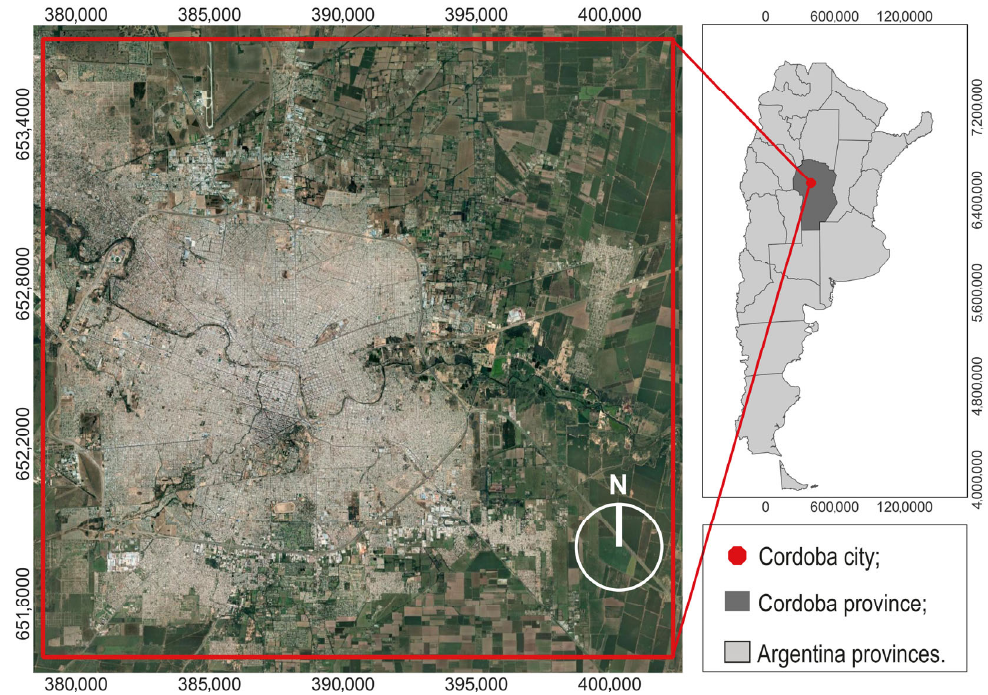
Figure 1. In red: the metropolitan area of Cordoba city (study area, reference system: WGS 84 UTM 20 S, epsg: 32720).